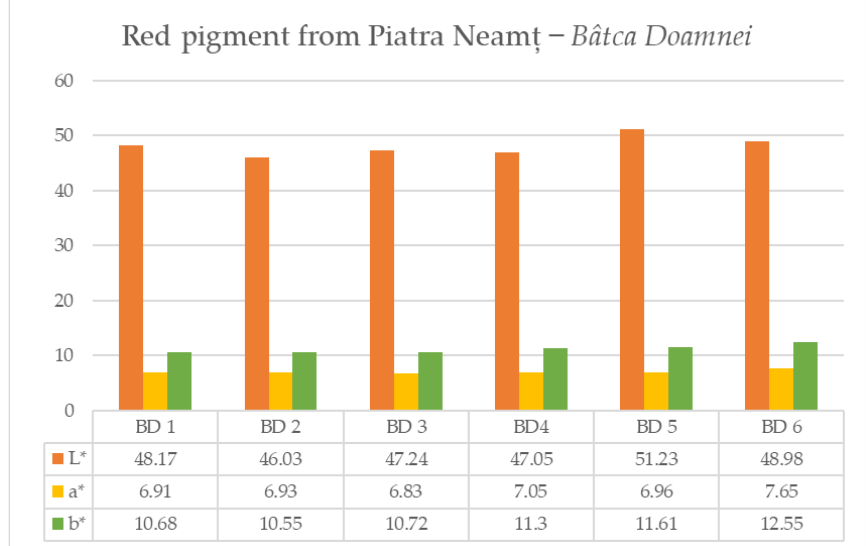
Figure 11. CIE L*a*b* colorimetry for the red pigment from Piatra Neam ț — Bâtca Doamnei.